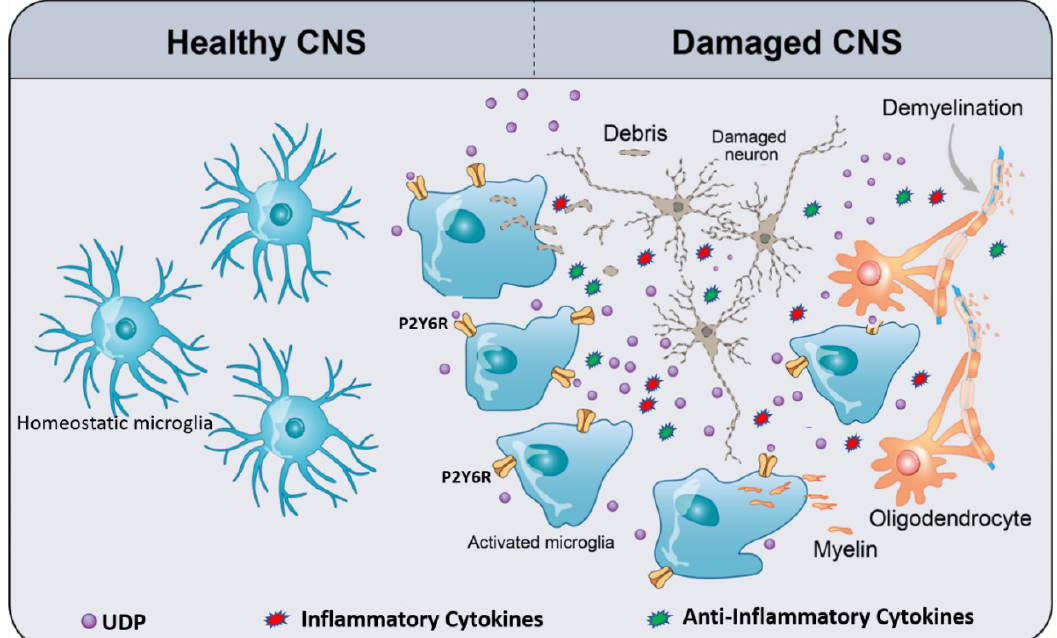
Figure 1. Schematic of UDP / P2Y6R signaling, mediating microglial phagocytosis and chemotaxis. In the healthy CNS, homeostatic microglia (resting microglia) constantly survey and scan the cerebral microenvironment by continuously extending and retracting their ramified processes for the early recognition of damage-associated molecular patterns (DAMPs) such as ATP. Damaged CNS elements (neurons and oligodendrocytes) release or leak ATP / UTP. Furthermore, UTP is easily converted to UDP by ectonucleotidases. UDP acts as an “find-me” signal for P2Y6R. UDP / P2Y6R activates microglia, activated microglia move to the damaged area, and then subsequently recognize UDP as “find-us” signal, attached to the targets, and engulf them. As a result of microglia activation, they release a plethora of inflammatory and anti-inflammatory cytokines depending on the context of the disease. The types and levels of released cytokines differ from a disease to another. The context of a specific disease determines the harmful or the beneficial effects of microglia activation.